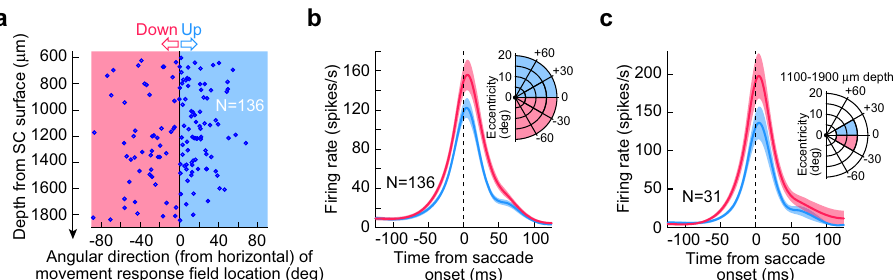
Fig. 1 Superior colliculus (SC) saccade-related motor bursts are stronger for downward saccades than for upward saccades, even when controlling for depth from the SC surface. a We picked neurons matched for depth from the SC surface (between 600 and 1850 μ m) but having movement fi eld hotspot locations in either the upper (light blue) or lower (light red) visual fi elds (i.e., positive or negative directions from the horizontal meridian, respectively). Note that the upper visual fi eld neurons appear compressed along the direction dimension (i.e., in visual coordinates), likely due to upper visual fi eld neural tissue magni fi cation 23 . Such magni fi cation is similar, in principle, to foveal magni fi cation of SC neural tissue 33 . b For the neurons in ( a ), we plotted peri- saccadic fi ring rates for saccades towards each neuron ’ s preferred movement fi eld location 23 . Saccade-related bursts were stronger for lower visual fi eld than upper visual fi eld neurons. c To better constrain errors in depth estimates from the SC surface (due to surface curvature), we further restricted the choice of neurons to those primarily near the horizontal meridian and at an eccentricity range associated with quasi-constant tissue curvature between upper and lower visual fi eld locations 33 ; the ranges of amplitudes, directions, and depths are shown in the inset. The motor bursts of the resulting 31 neurons were still stronger for lower visual fi eld than upper visual fi eld neurons (left panel). Error bars in all panels